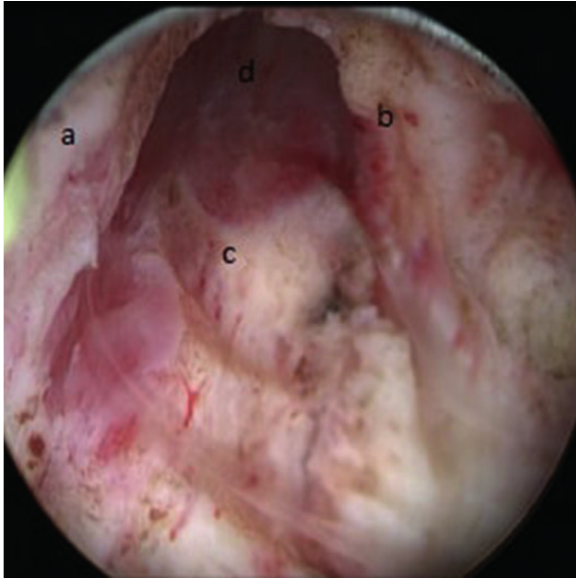
figure 3 - Retrograde view of resected prostate. a) Resected right lateral lobe, b) Resected left lateral lobe, c) Resected median lobe, d)